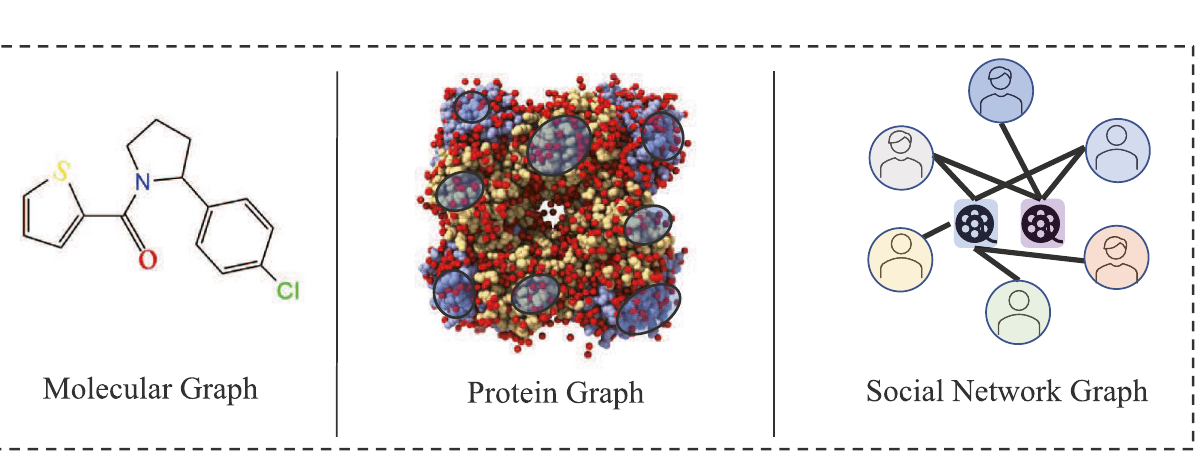
Figure 3. The example of visualization graph for molecular graph, protein graph generated from the public protein file bank 45 and social network